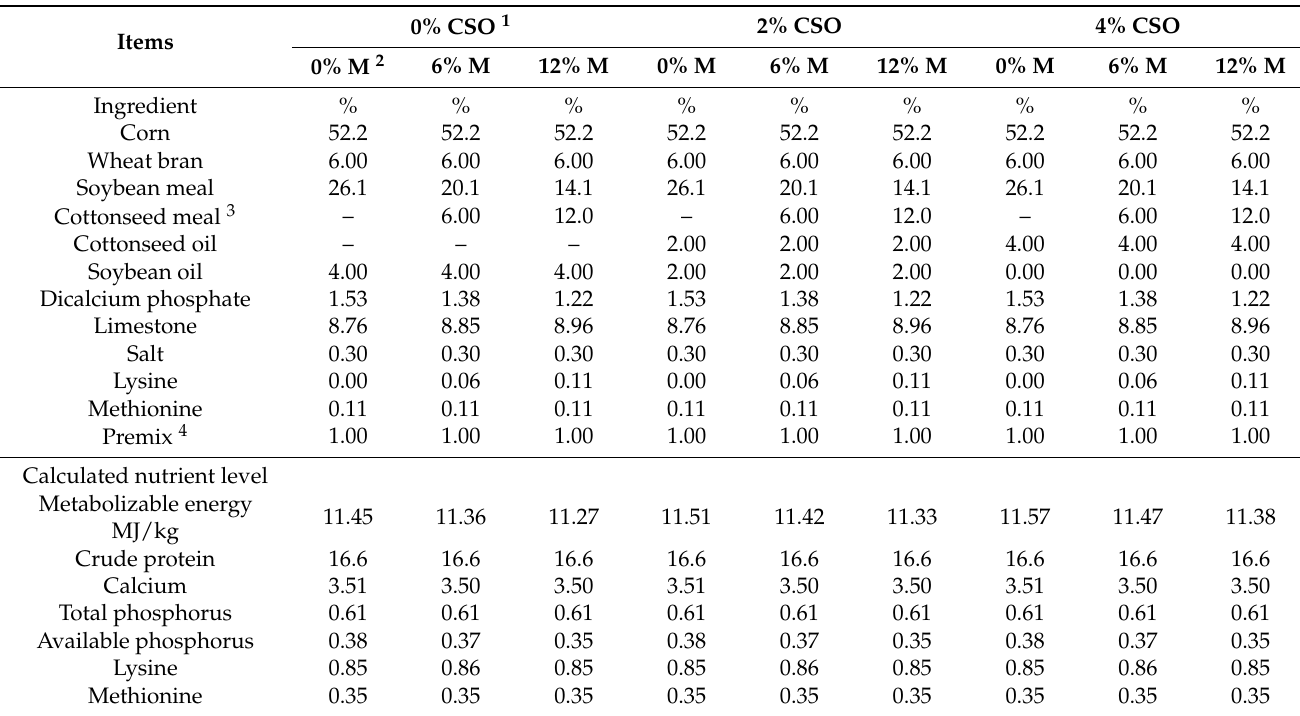
Table 2. Diets composition and nutrient